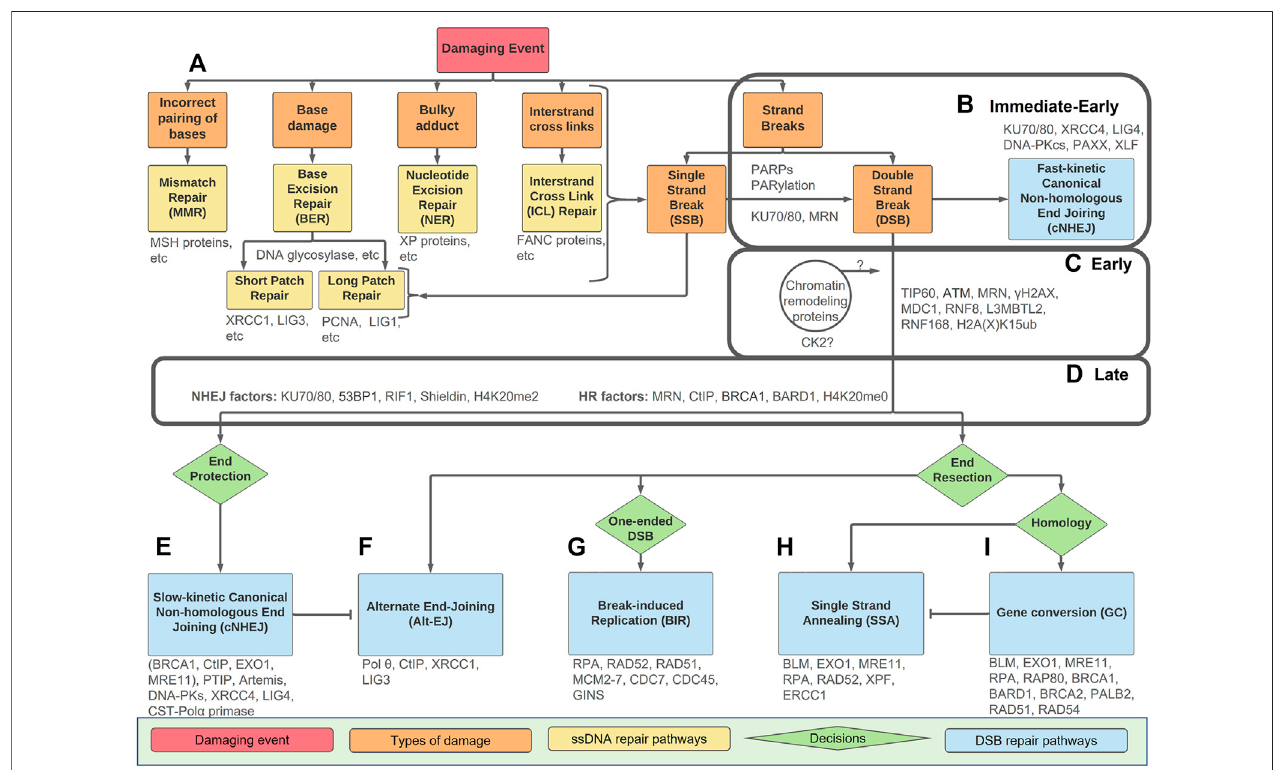
FIGURE 1 | An overview of types of DNA damage and repair pathways with the Immediate-Early, Early, and Late stage indicated. The Immediate-Early, Early, and LatestagesoftheDSBresponseareindicatedintheboxes. (A) MismatchednucleotidesorDNAdamage(orangeboxes)canbedividedinto fi vecategoriesanddirected towardstherepairpathwaysasindicated(yellow).AnyformofdamagecanbecomeSSBsorDSBsifnotrepairedcorrectly. (B) Strandbreaks,eitherSSBsorDSB,have aPARP/PARylationresponse.IntheImmediate-Earlyresponse,thePARP/PARylationcanfacilitaterecruitmentofKU70/80andMRNtosomeDSBs.Ifthebreakis easily ligatable, fast-kinetic cNHEJ (blue) repairs the damage within the Immediate-Early response without any requirement for PARylation, processing or ATM- dependentsignalling. (C) Ifthebreakrequiresprocessingpriortorepair,theEarlyresponseisactivated.ThisincludesATM-dependentsignallingwhichrequiresdynamic chromatin remodelling. The Early response culminates in the ubiquitination of H2A(X)K15. How chromatin events and CK2 activation tie into these processes remains unclear. (D) The Late response includes 53BP1 and BRCA1-BARD1 as ‘ readers ’ of the H2A(X) ubiquitin mark as well as the methylation state of H4K20. The Late responseoccurspriortopathwaychoiceandincludesanintricatebalanceofend-resectionvs.end-protectionmachinery. (E – I) Downstreamrepairpathways(blue)with decision points between pathways (green). Slow-kinetic cNHEJ and GC are high- fi delity repairs, while Alt-EJ, BIR, and SSA, are mutagenic and result when repair machinery is not available. Key proteins discussed are in